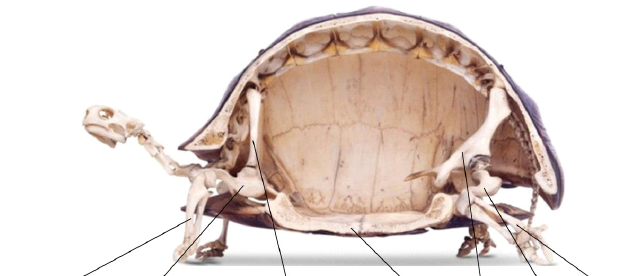
Figure 1. Tortoise’s bone structure.